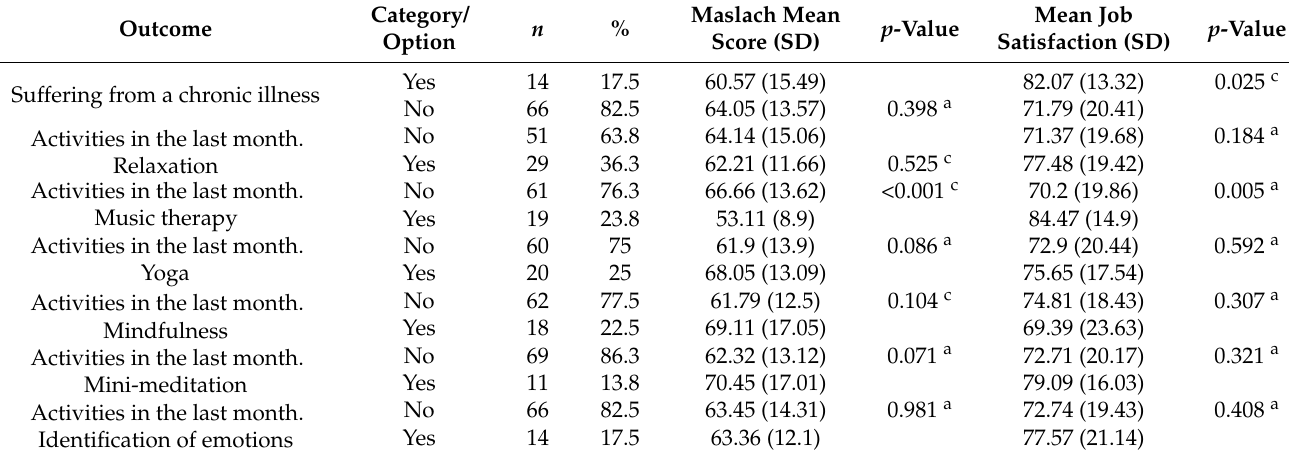
Table 1. Occupational health characteristics of the sample and the relationship with the Maslach’s scores and the level of job